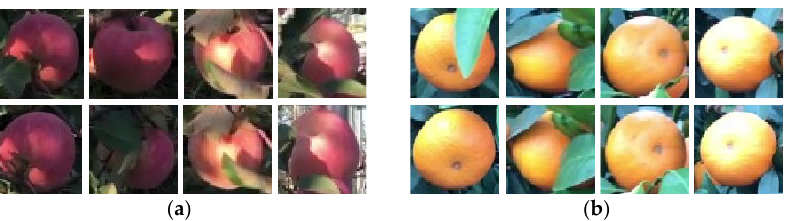
Figure 11. Samples of fruit pairs for the training of the fruit matching model. ( a ) Training samples of apple image pairs. ( b ) Training samples of orange image pairs.